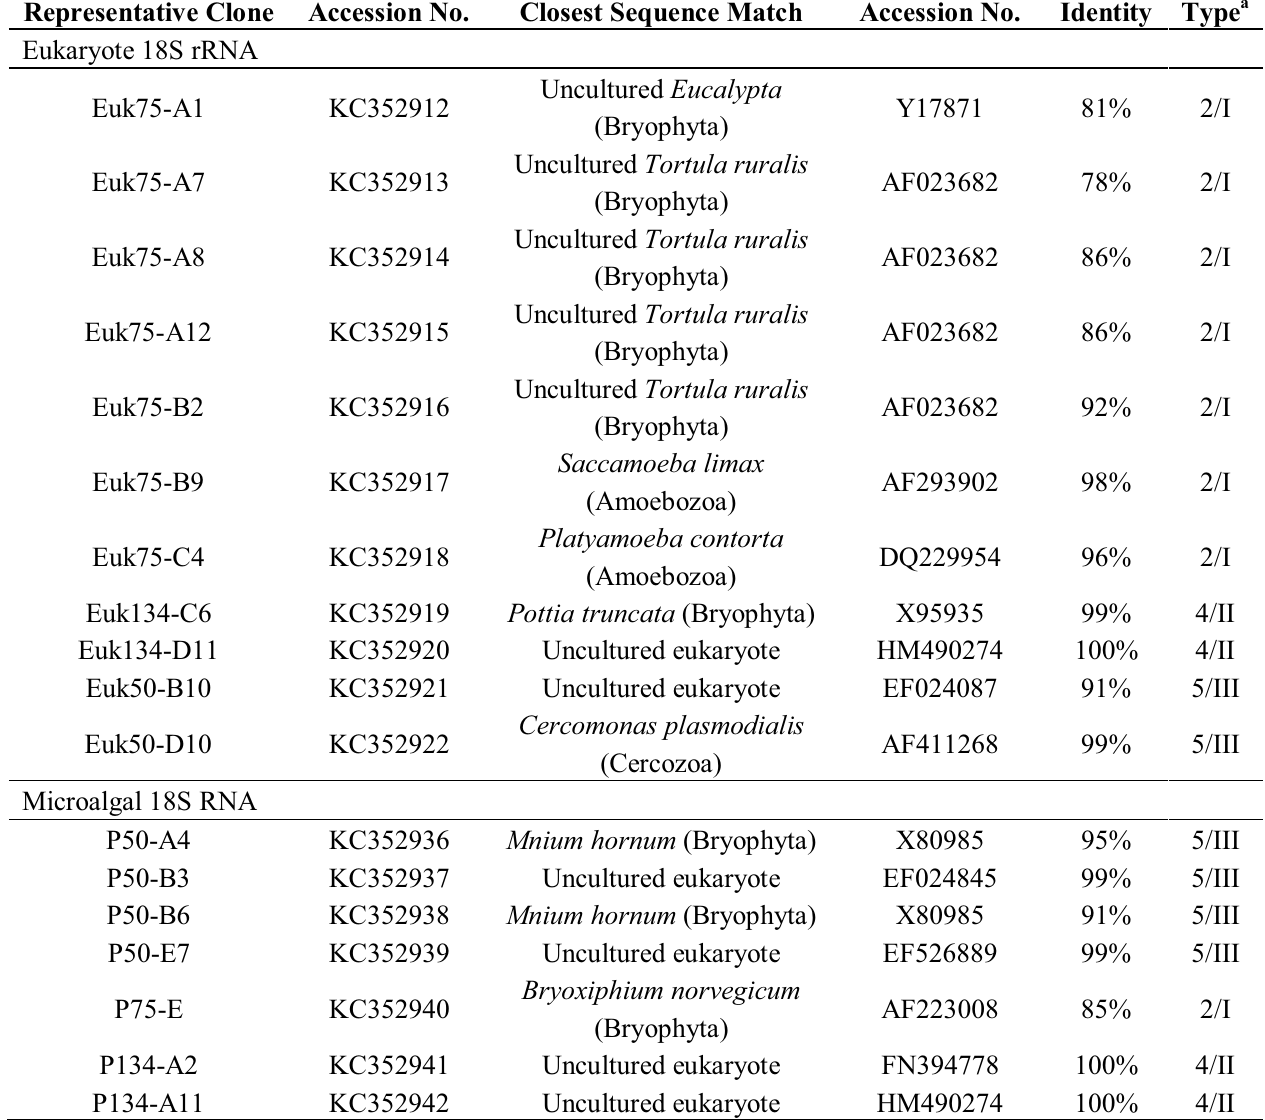
Table 2. Affiliation of the clones sampled from hypolithic communities. Representative Clone Accession